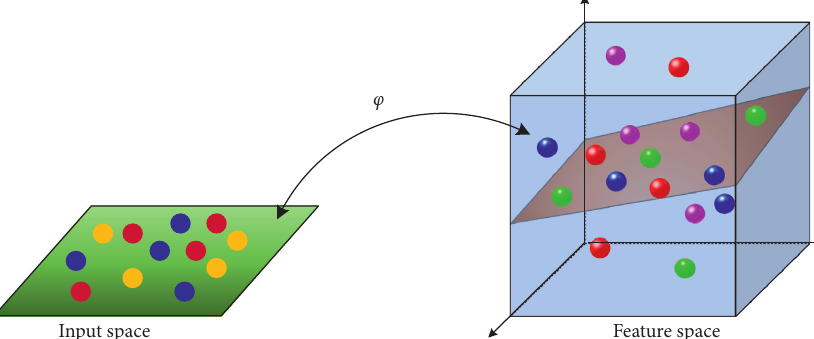
Figure 3: Schematic diagram of kernel function mapping of support vector machine.